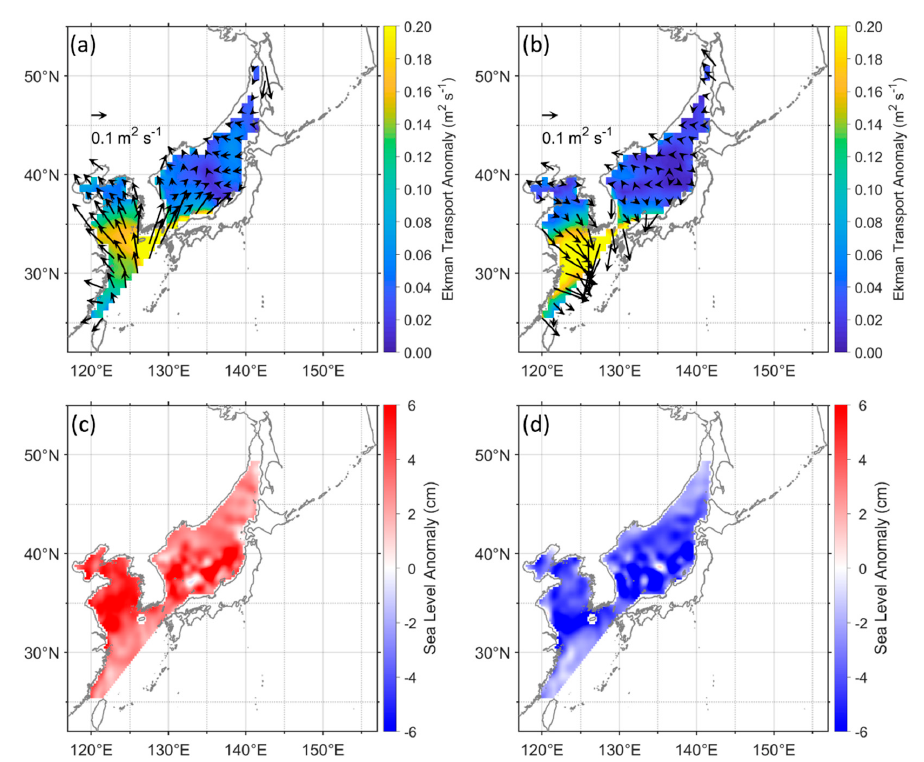
Figure 6. The Ekman transport anomaly per unit width based on Equation (1) during the periods ( a ) H and ( b ) L. The strength and direction of the Ekman transport anomaly are shown with color and vector. The NEAMS sea-level distribution derived from satellite altimetry observations during the periods ( c ) H and ( d ) L.